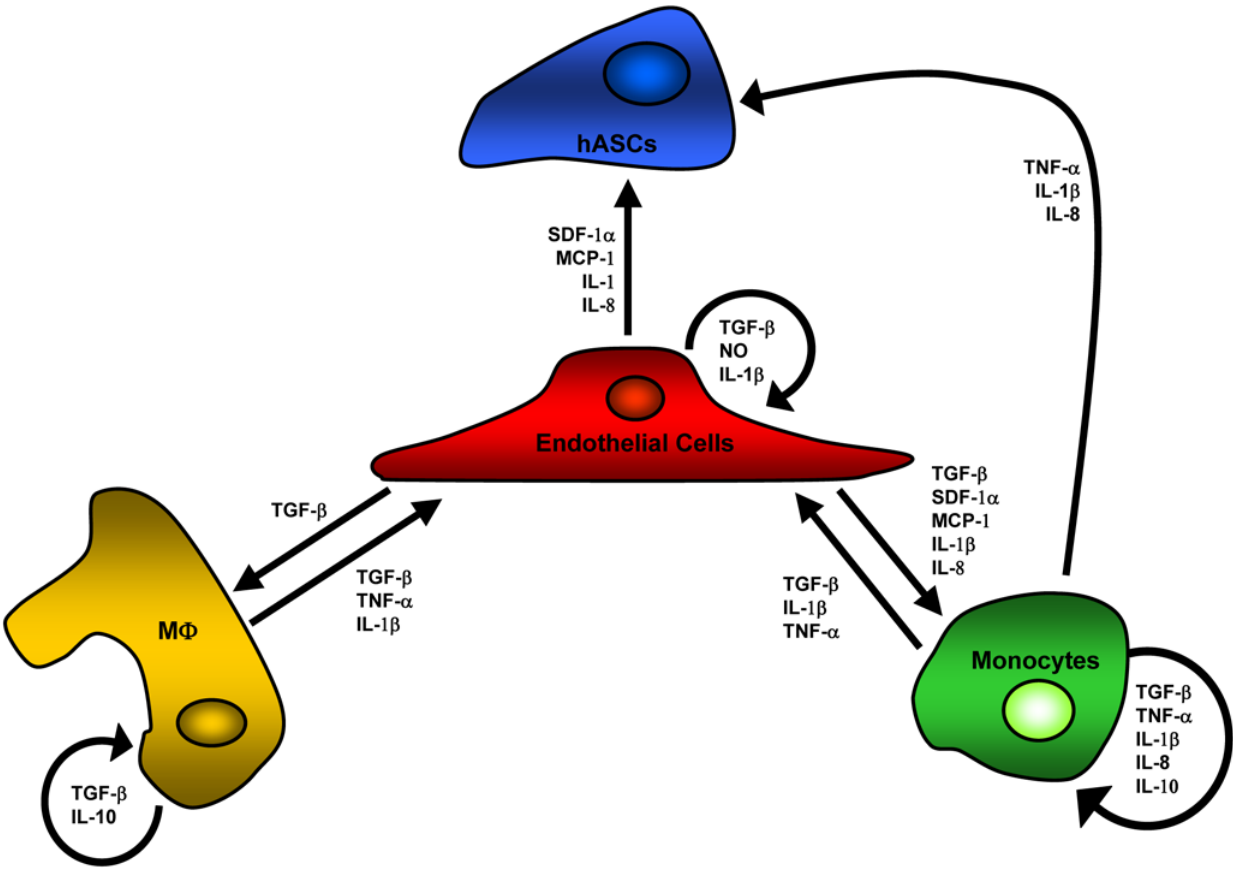
Figure 12. Complex and dynamic connections between agents exist in the ABM. Arrows indicate connections between populations of cells and denote some combination of the following: induced secretion, changes in cellular adhesion molecule expression, and/or integrin activation. These chemokines and cytokines have all been implicated in human ischemic injury, and all connections between cell types are based on relevant, independent, experimental